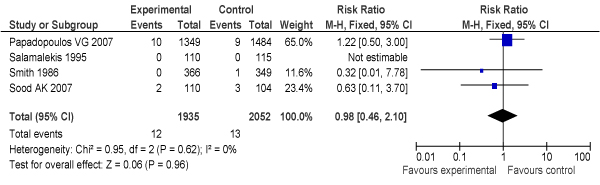
Meta-analysis (Forest plot, Fixed effects model) of impact of vibroacoustic stimulation versus mock or no stimulation on intrauterine or perinatal deaths.